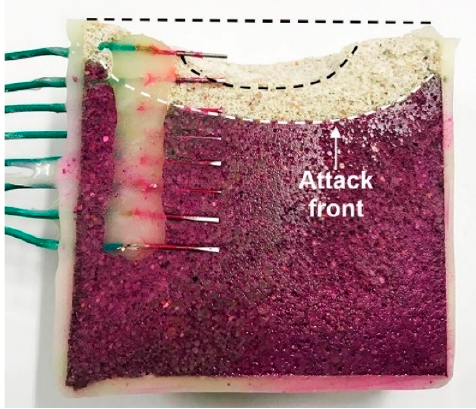
Figure 5. Cross section of mortar sample after 50 days of acid attack. Red color is due to the presence of phenolphthalein identifying the region with pH > 9.